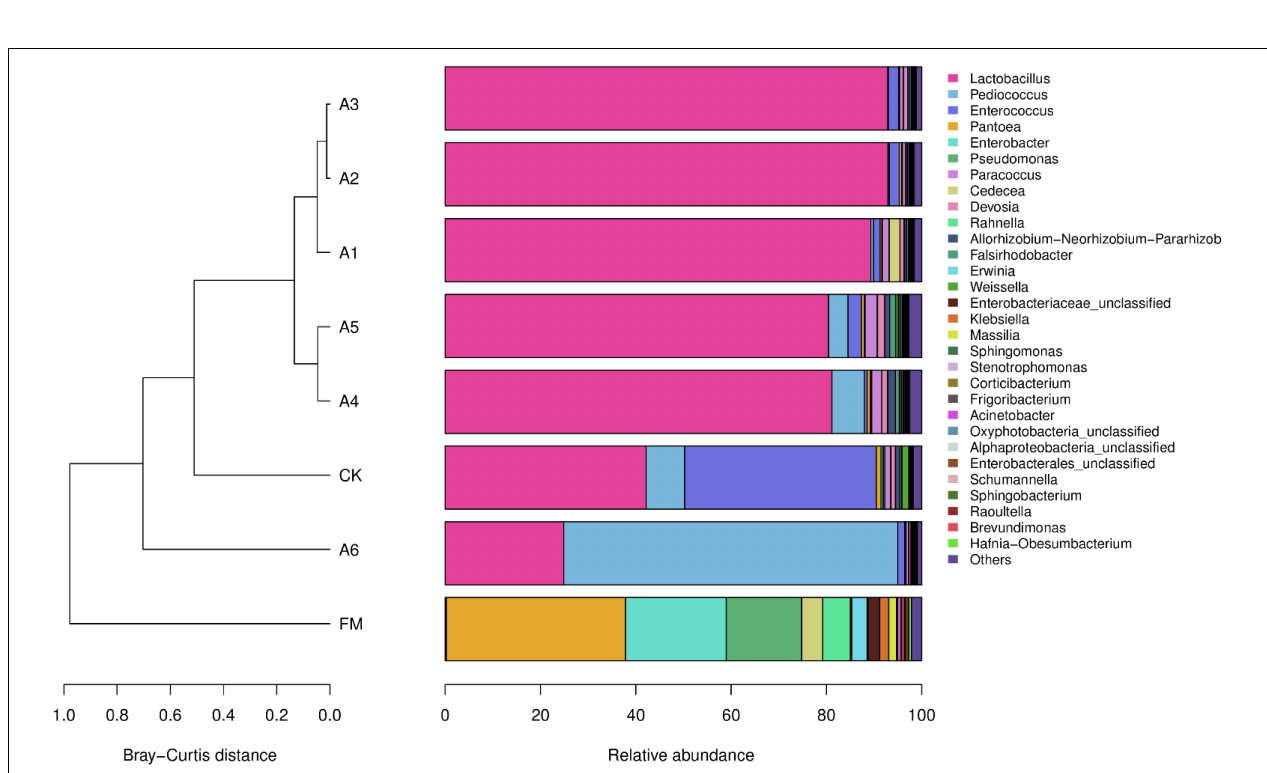
FIGURE 2 | Relative abundance of the bacterial community (genus level) in silages and fresh materials (FM) ( n = 4). FM, fresh materials; CK (Control), 2.00 ml/kg fresh weight (FW) of distilled water; A1, 2 g/t FW of the first additive and 2.00 ml/kg FW of distilled water; A2, 2 g/t FW of the second additive and 2.00 ml/kg FW of distilled water; A3, 5 g/t FW of the third additive and 2.00 ml/kg FW of distilled water; A4, 1 g/t FW of the fourth additive and 2.00 ml/kg FW of distilled water; A5, 1 g/t FW of the fifth additive and 2.00 ml/kg FW of distilled water; A6, 1 g/t FW of the sixth additive and 2.00 ml/kg FW of distilled water.